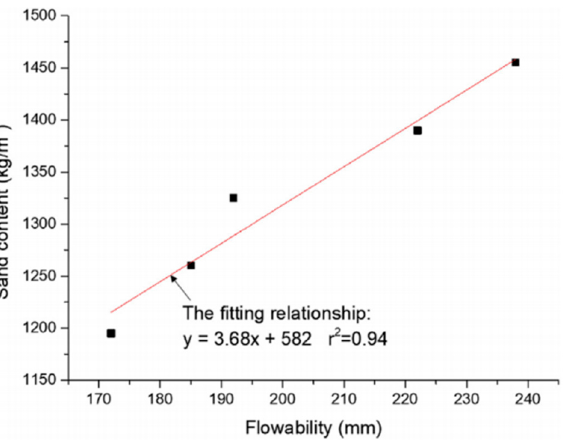
Figure 2. Relationship between the flowability of cement paste and the optimum amount of natural sand. Reprinted with permission from ref. [18]. Copyright 2019 Elsevier Ltd.